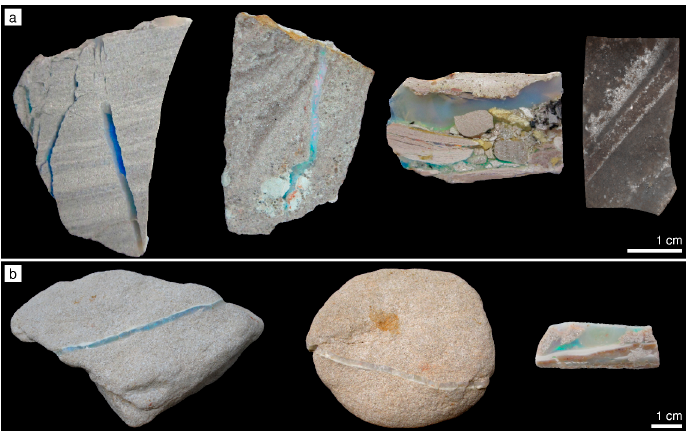
Figure 2. Photographs of polished thick sections of samples from Andamooka ( a ) and raw, unprepared sample material from Mintabie ( b ). ( a ) Andamooka samples, from left to right: opal-filled extensional fractures crosscut the bedding in a bleached sandstone; precious opal in an extensional fracture in sandstone with clay clasts; conglomerate with abundant opal cement and large clasts containing pseudomorphs after carbonates; laminated chert sample with oolitic structures and opal pseudomorphs after rhombohedral crystals. ( b ) Mintabie samples, from left to right: bleached sandstone with precious and common (white) vein opal; bleached sandstone with predominantly common (white and translucent) vein opal; sandstone fragments in a sample composed of varicolored common opal with minor precious opal domains.